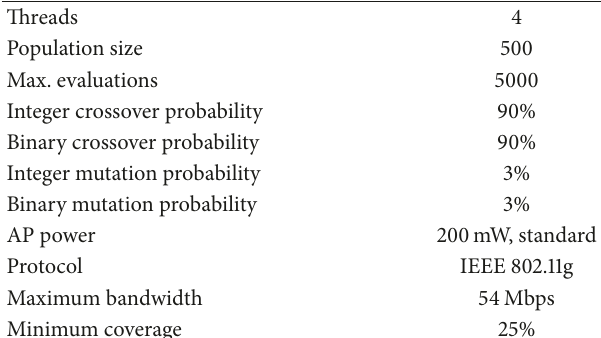
Table 3: Parameter settings for